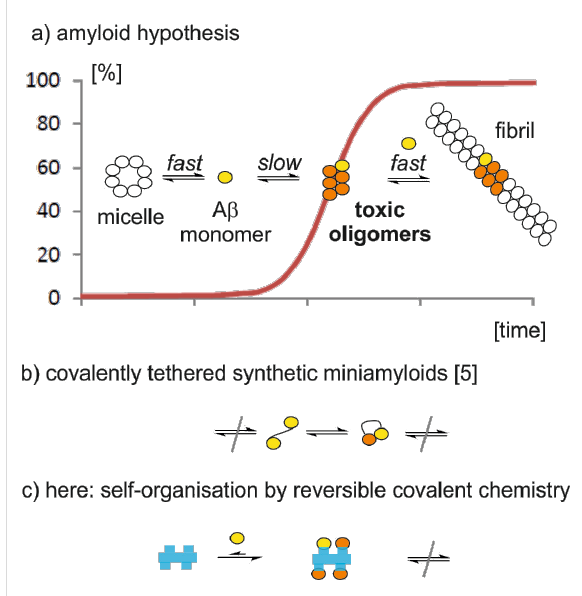
Figure 1: a) Schematic representation of the A β fibril formation. The monomeric peptide is shown as a colored ball to indicate the unfolded (yellow) or the β -sheet (orange) conformation. Micellar aggregates of A β are in equilibrium with dissolved monomers. The autocatalytic and irreversible fibril formation starts after an induction phase with a sigmoidal behavior. b) Covalent tethering of A β peptides mimics the first step of fibril formation. Additional charged amino acids prevent the further aggregation of covalently tethered oligomers. c) The reversible covalent tethering of A β peptides on an organic template (blue bar) is topic of the present study. The spacing of attachment sites supports the cooperative interaction between A β peptides, while the size of the template limits the aggregation